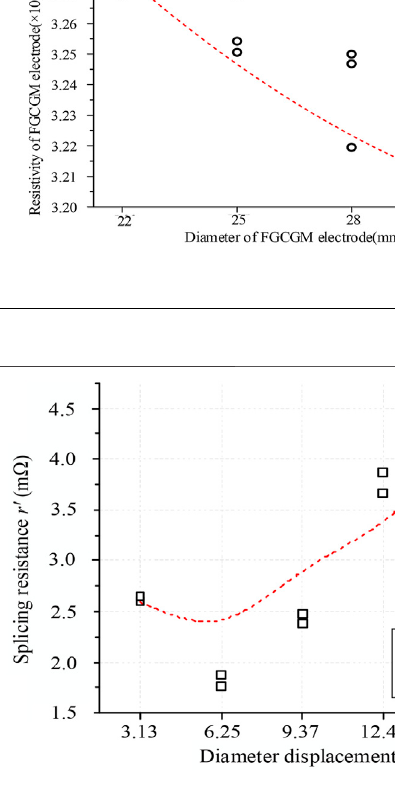
FIGURE 5 | Splicingresistance ofdifferent diameter displacement